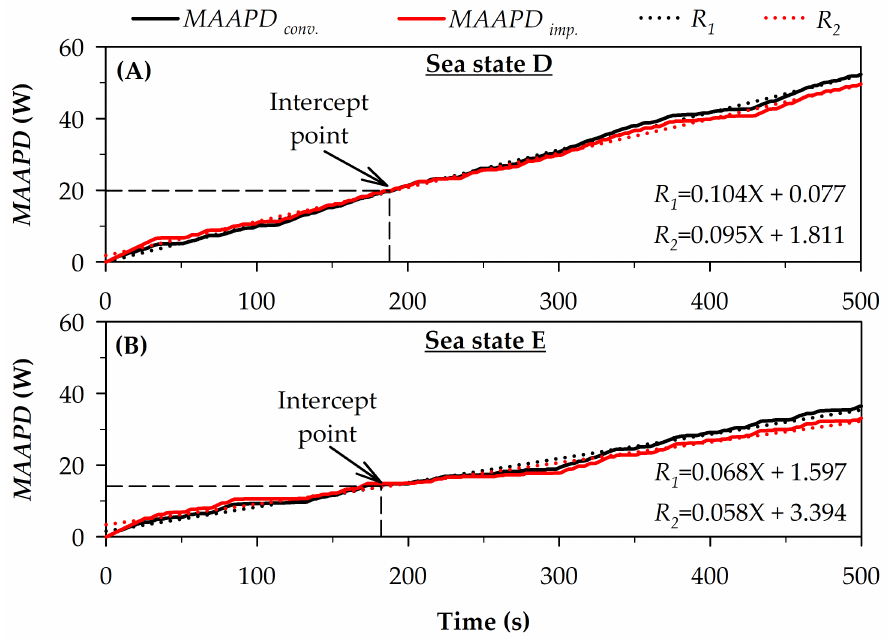
Figure 22. A comparison of MAAPD for conventional and improved HPTO unit models for the different wave peak period